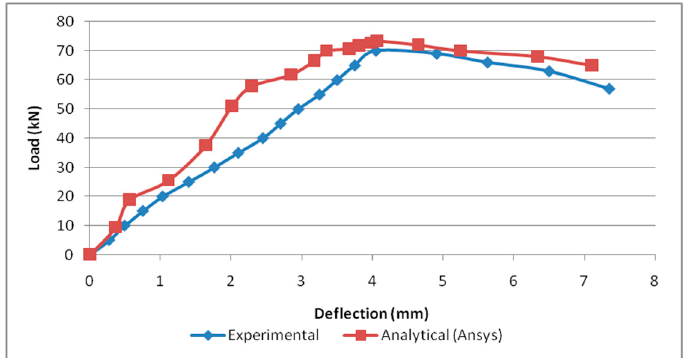
Figure 16. Load vs. deflection for B2B100.